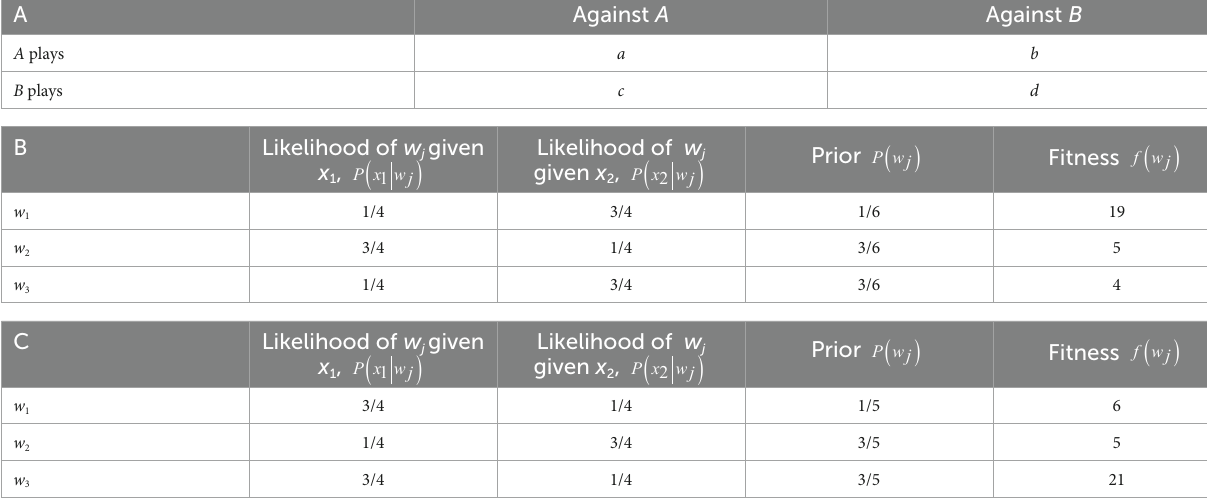
TABLE 1 A payoff matrix in evolutionary game theory for two strategies, A and B. A Against A Against